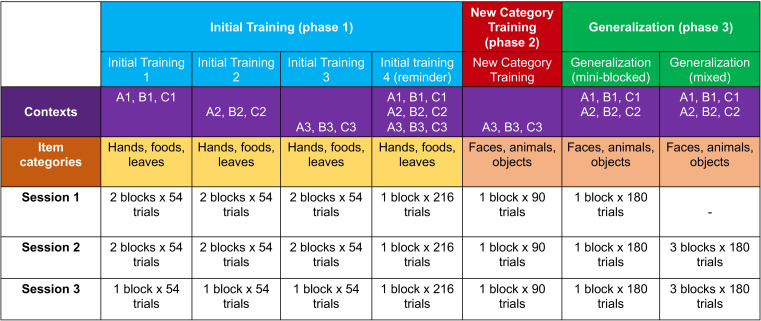
Schematic showing design of whole experiment over multiple sessions.Note that contexts seen in new category training and held out of generalization were not necessarily from Initial Training 3, but these are shown only as an example here. The mixed generalization phase did not take place in session 1. Only participants who passed the accuracy criterion in the generalization phase in session 1 completed the mixed generalization phase in the scanner, while participants who failed to meet this criterion completed this phase behaviorally. All other sections of the experiment took place outside of the scanner.